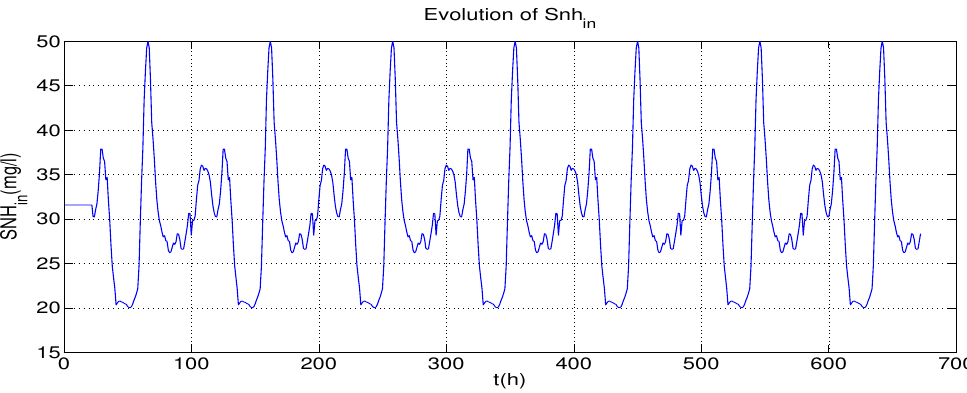
for stormy weather. in